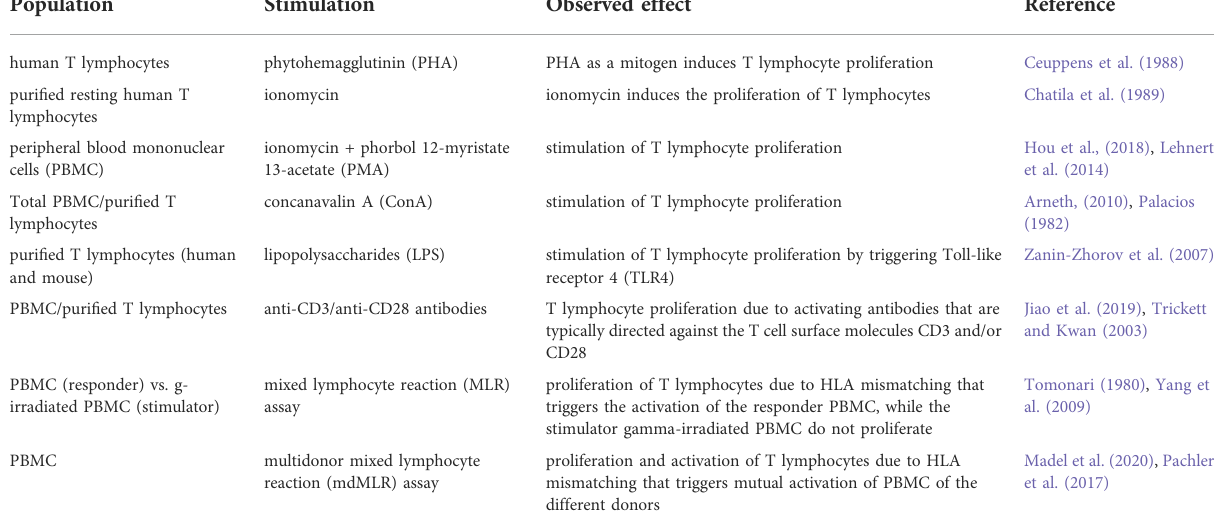
TABLE 1 Type of stimuli used in T-cell